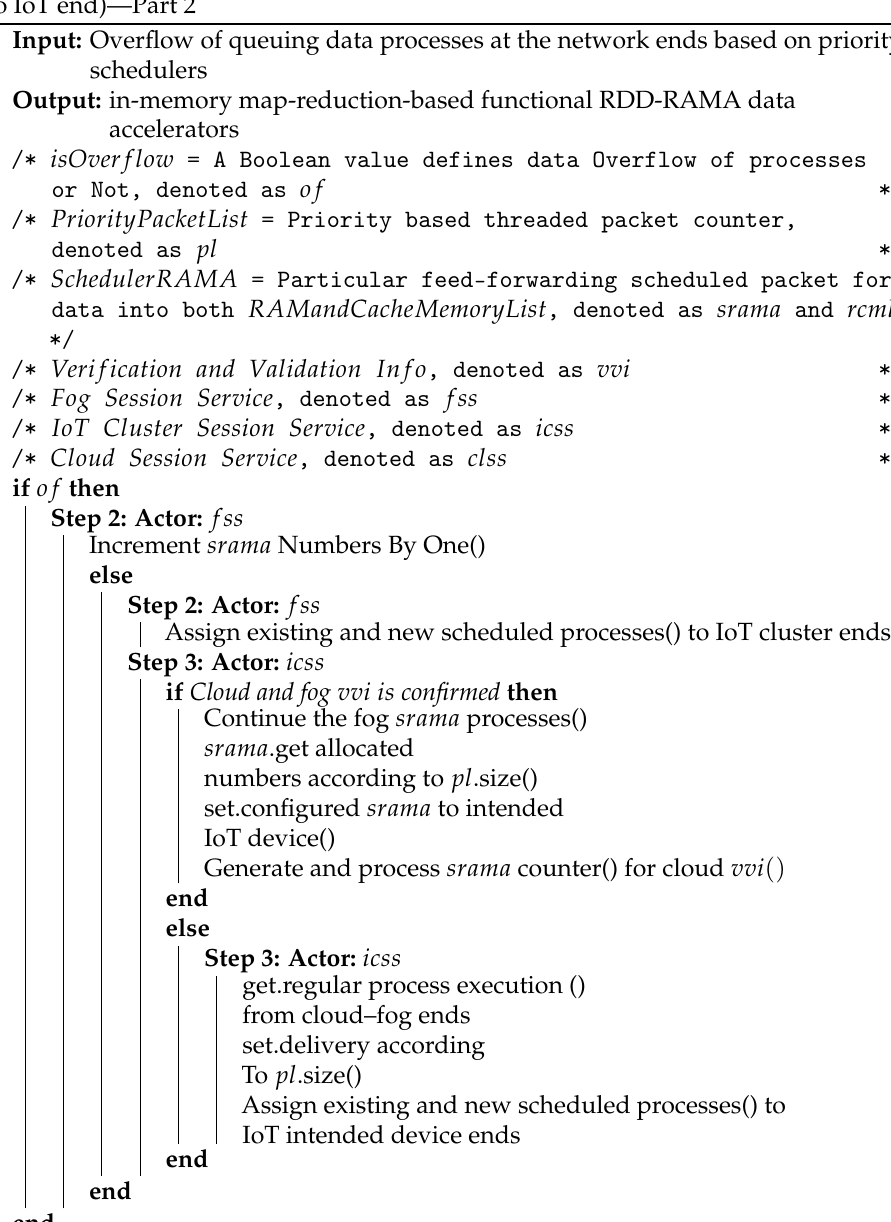
Algorithm 2: BDPS—delay efficient scheme for rapid data delivery (cloud,